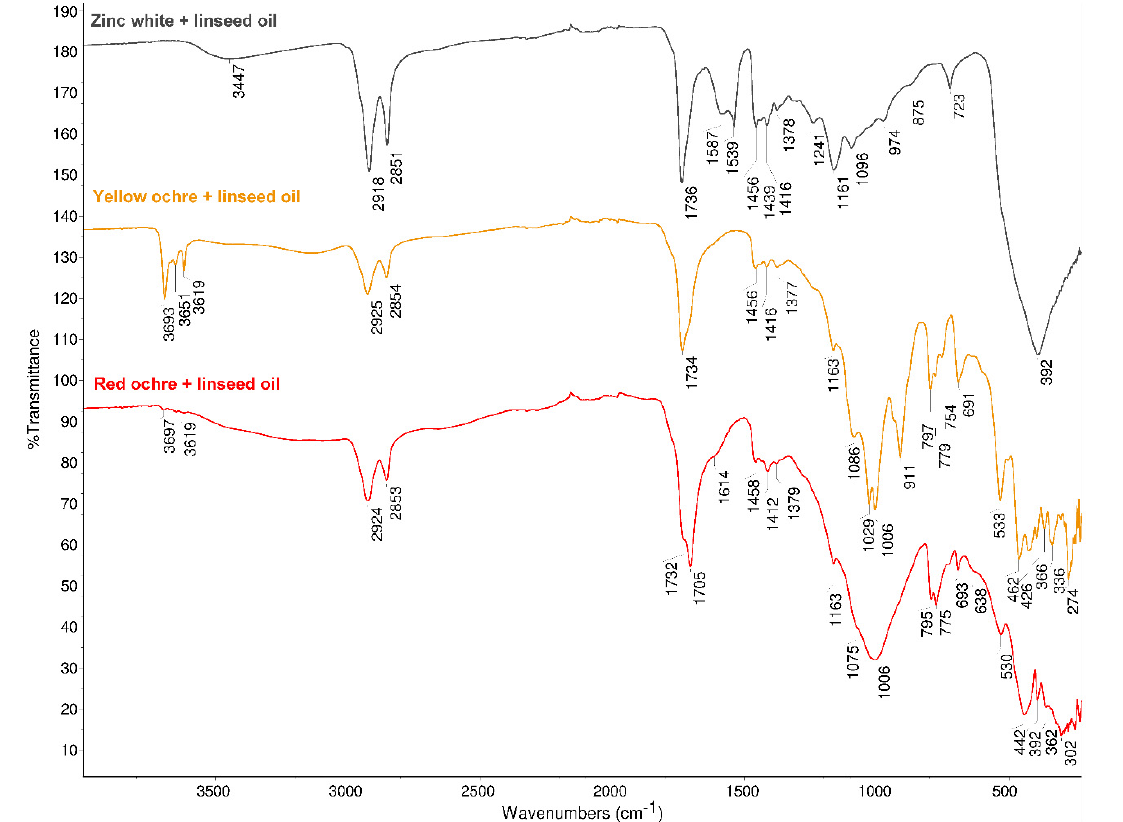
Figure 2. Attenuated total reflection Fourier transform infrared (ATR–FT–IR) spectra of aged paint mock-ups, pigment concentration 50 g/100 g. The spectra of the mixtures containing other pigments (pigment concentration 50 g/100 g) are presented in the Supplementary Materials.